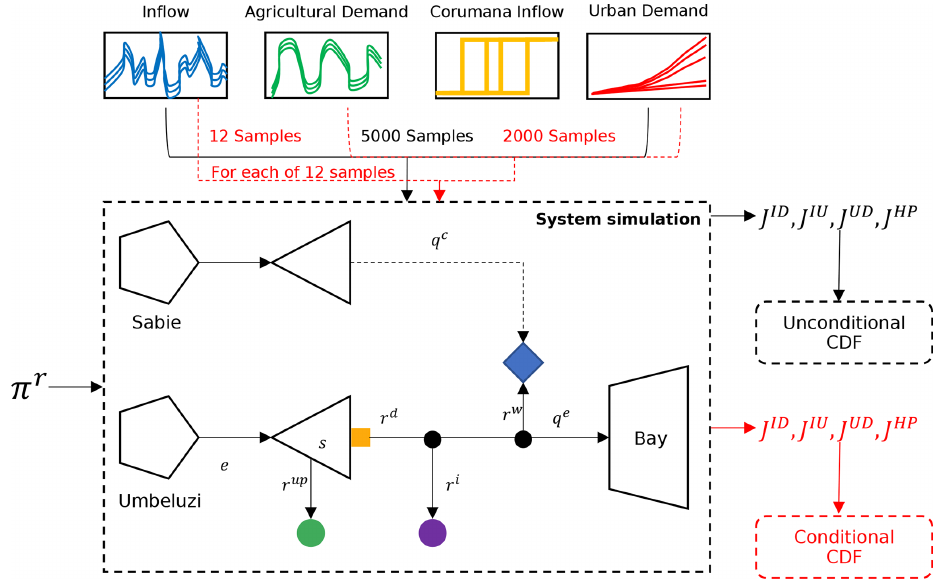
Figure 4. PAWN conceptual framework, with the unconditional objective function distribution in black and conditional objective function distribution in red.